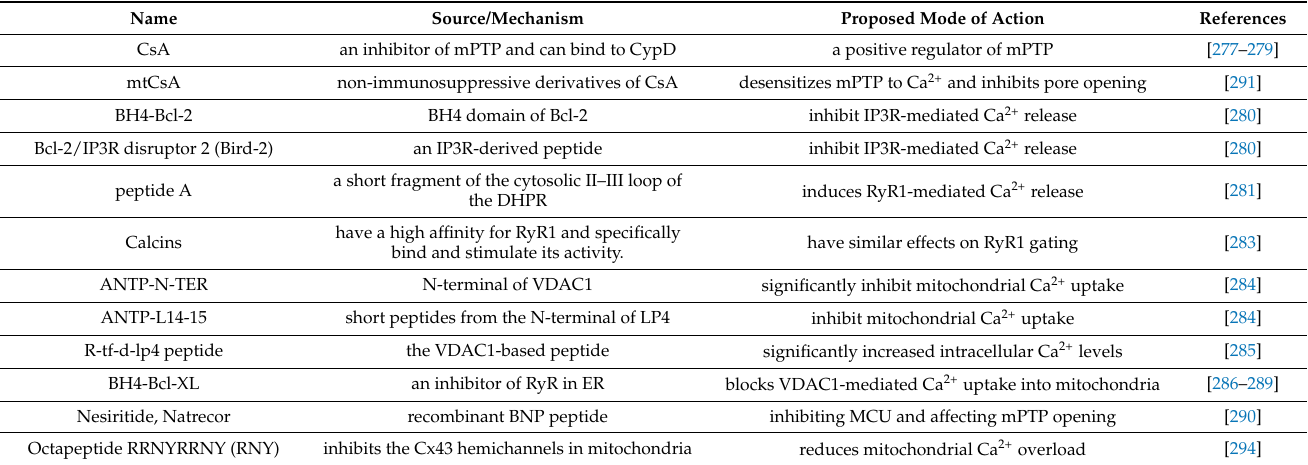
Table 1. Inhibitors and peptides that target mitochondrial